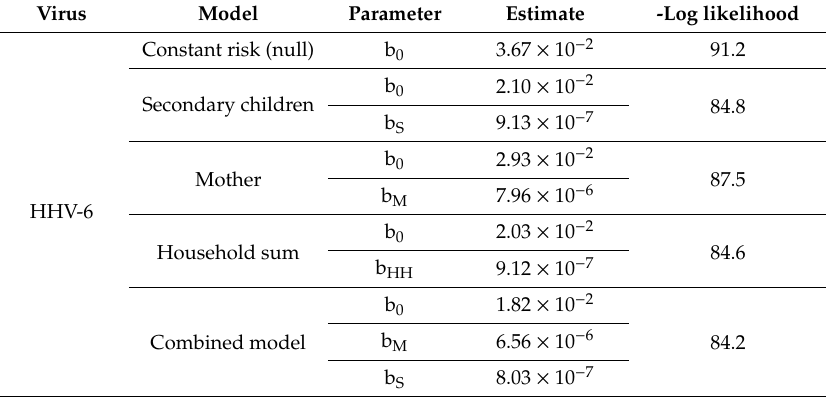
Figure A2. Transmission model sensitivity analysis to exposure interpolation and infection status. ( a ) Summary of interpolation by household (points) by maximum consecutive weeks interpolated and percentage of exposures weeks interpolation by exposure source for each virus. ( b ) Estimated exposure risk coe ffi cients for each virus allowing for a maximum total interpolation by household. For example, the risk estimate at 20% maximum interpolation includes only households with 20% interpolation or less. Estimates shown for both individual (single exposure) and combined exposure models. All households are included at 60%. Table A1. Coe ffi cient estimates and log likelihood from the survival analysis. For CMV, the log likelihood value was equivalent for all models (see equations (1 – 2) and Appendix A).